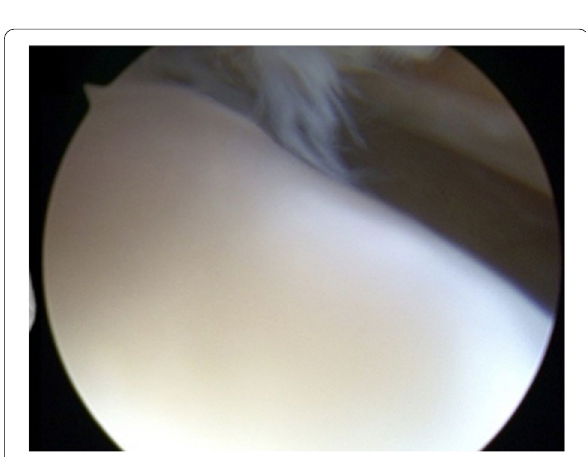
Fig. 10 Second-look arthroscopy revealed a healed patellar lesion and fibrillations of the patella (Grade II according to ICRS classification). 324